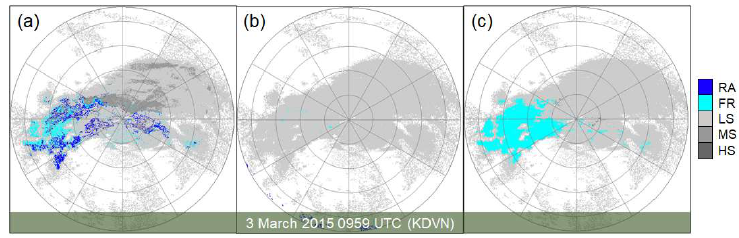
Figure 8. Example maps of ( a ) base scan reflectivity, ( b ) classification by the baseline method, and ( c ) classification by RF. The circular lines centered on the radar site demarcate every 50 km within a 230 km radar domain. The radial lines are positioned with a 30° interval.